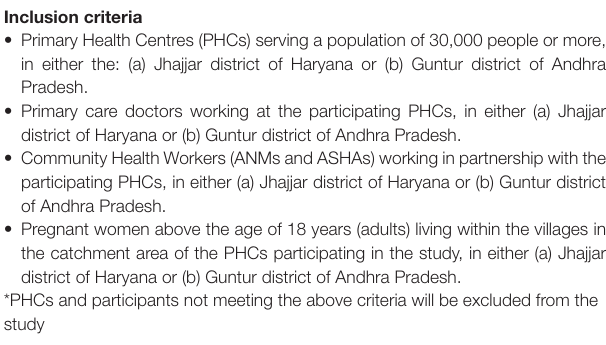
TABLE 1 | Summary of inclusion criteria for the study.